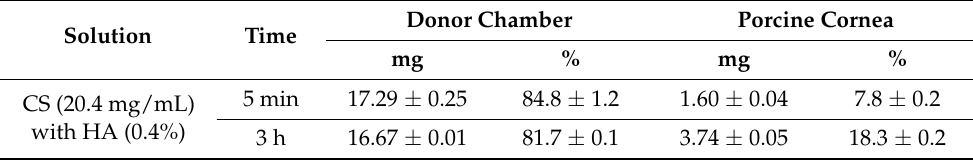
Table 2. The amount of CS determined in the donor part of the Franz cell and in the porcine cornea after 5 min and 3 h corneal exposure to eye drops (CS 20.4 mg/mL, HA 0.4%) (mean ± SD, n = 3). Donor Solution Time